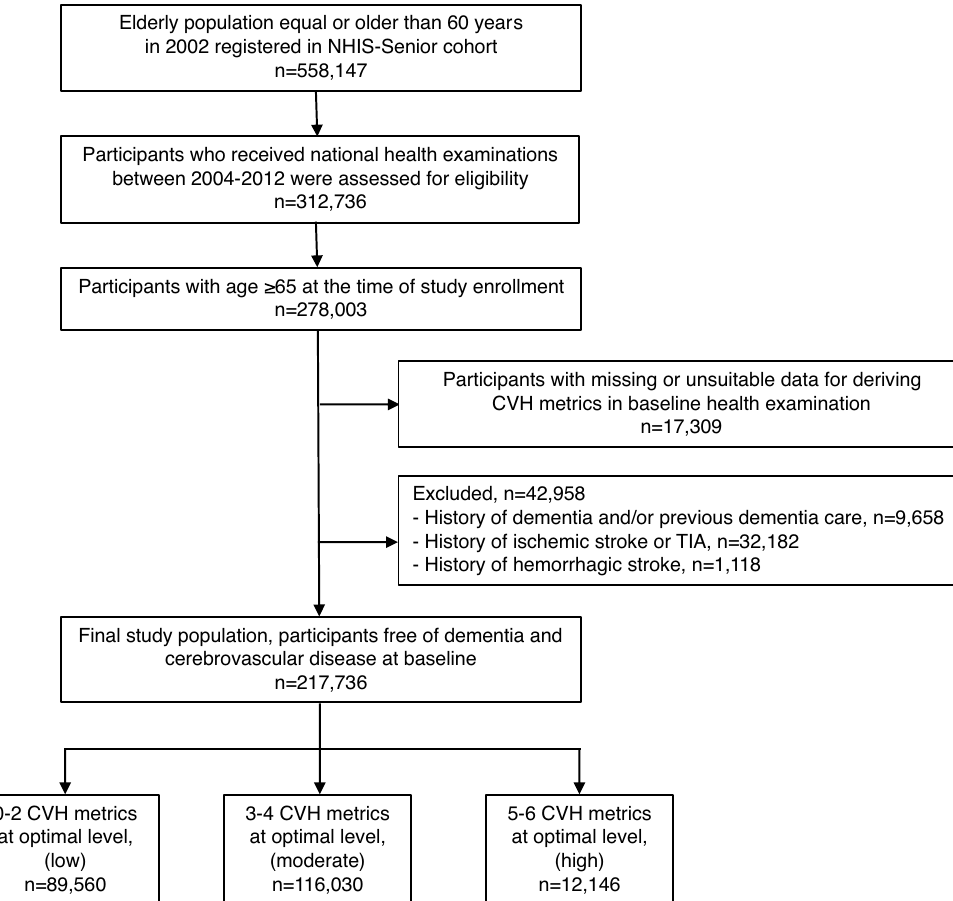
Figure 1. Flow-chart of study population selection. Abbreviations: CVH cardiovascular health, NHIS National Health Insurance Service of Korea, TIA , transient ischemic